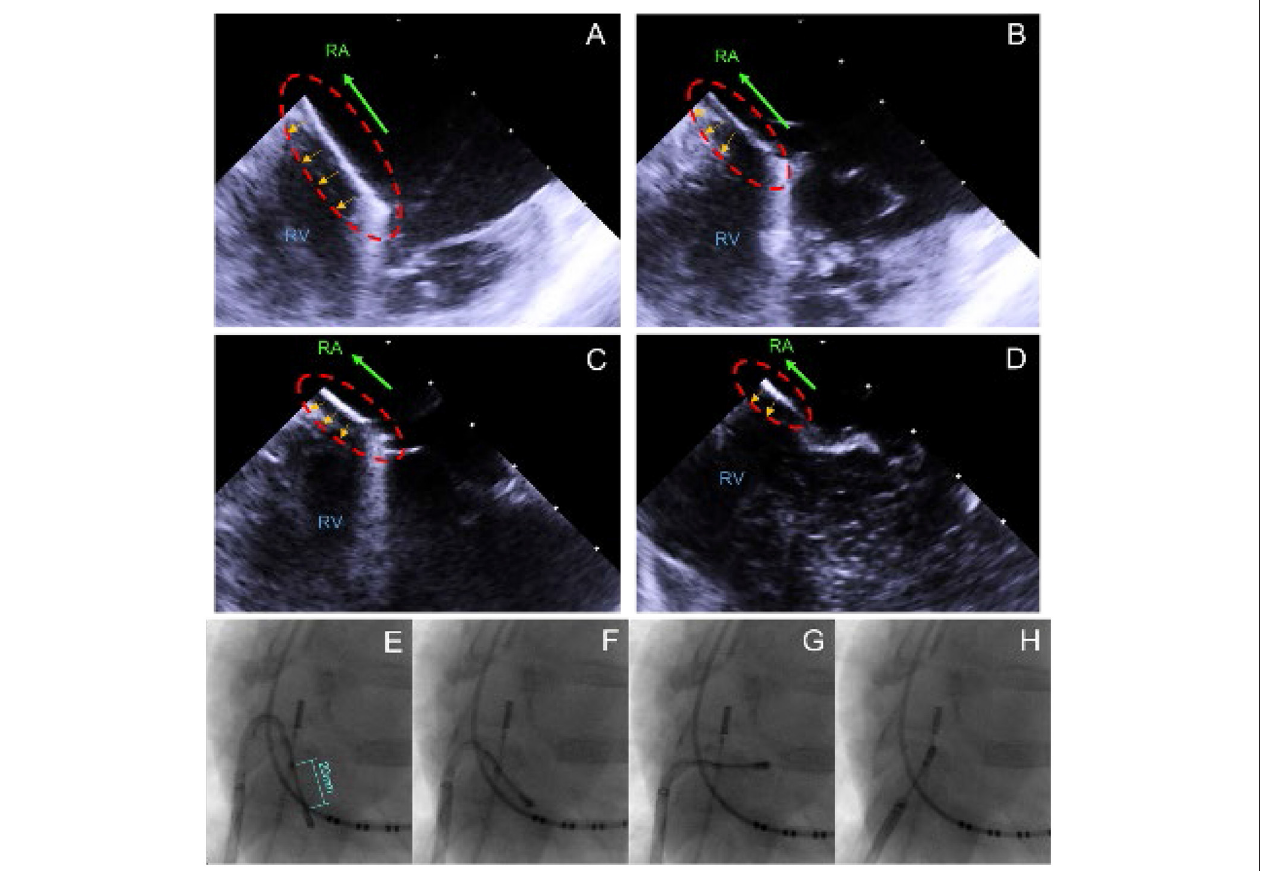
FIGURE 2 | ICE/X-ray recordings captured during the CTI ablation, visualizing the step-wise retraction from the RV/TCV toward the IVC. (A) Initial position with the catheter partially in the RV and on the TCV. (B–D) Stepwise retraction into the IVC. (E) Initial position with the catheter partially in the RV and on the TCV. (F–H) Stepwise retraction into the RA.